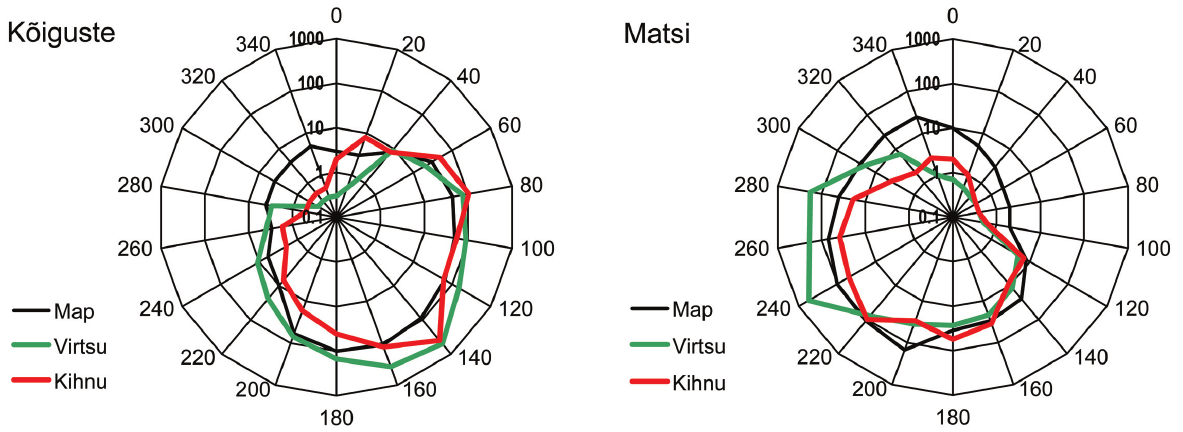
Fig. 2. Directional distributions of fetches used in the model at Kõiguste and Matsi. The initial values (map) are shown together with calibration results, which were independently obtained using Virtsu and Kihnu winds. The fetch is expressed on a logarithmic scale and varies between 0.5 and 500